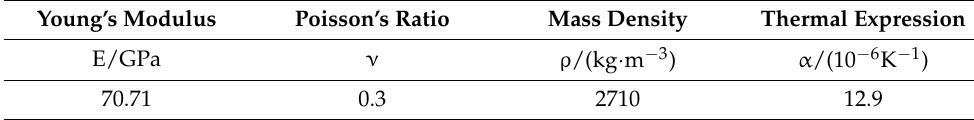
Table 1. The mechanical properties of the panel. Young’s